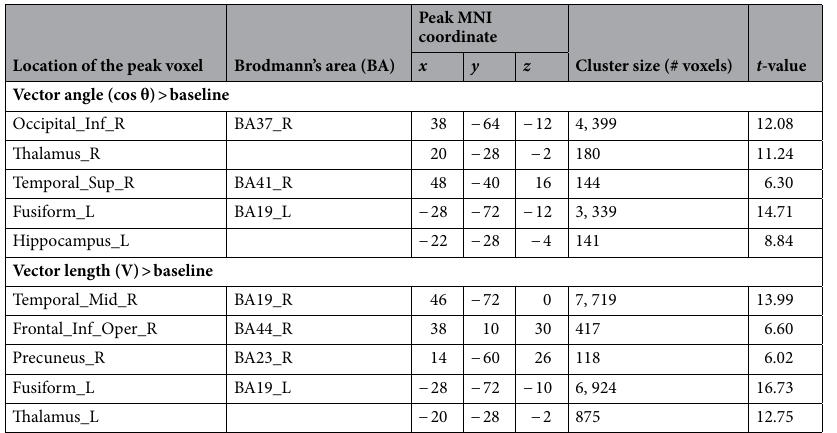
Table 1. Brain clusters showing significant difference in activation corresponding to the vector angle versus baseline and vector length versus baseline contrasts. The value was obtained using one-sample t -test. All clusters survived Gaussian random field (GRF) correction (voxel level p < 0.001 and cluster-level p < 0.05). Voxel size = 2 × 2 × 2 mm 3 . MNI Montreal Neurological Institute, Sup superior, Inf inferior, Mid middle, Oper opercular, Orb orbital, Ant anterior, L (R) left (right) hemisphere. The same